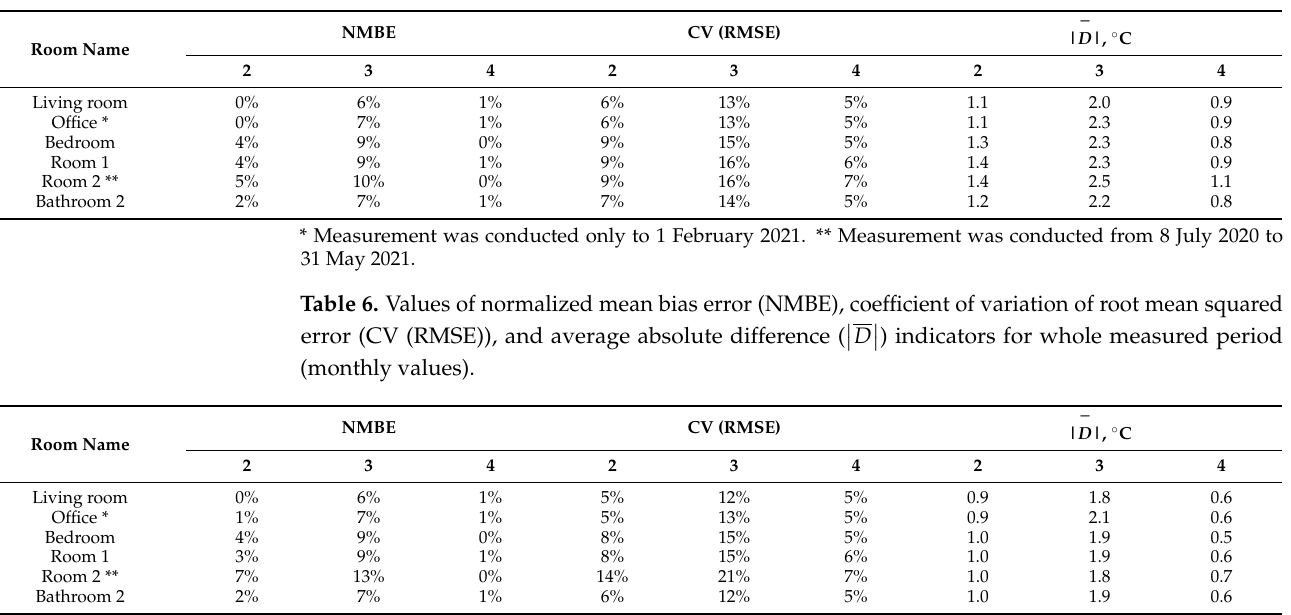
Figure 10. Indoor temperature measured and calculated (average hourly values) in December ( a ) in the living room; ( b ) in room 1. Table 5. Values of normalized mean bias error (NMBE), coefficient of variation of root mean squared error (cid:12) (cid:12) (CV (RMSE)), and average absolute difference (cid:12) D (cid:12) indicators for whole measured period (hourly values).